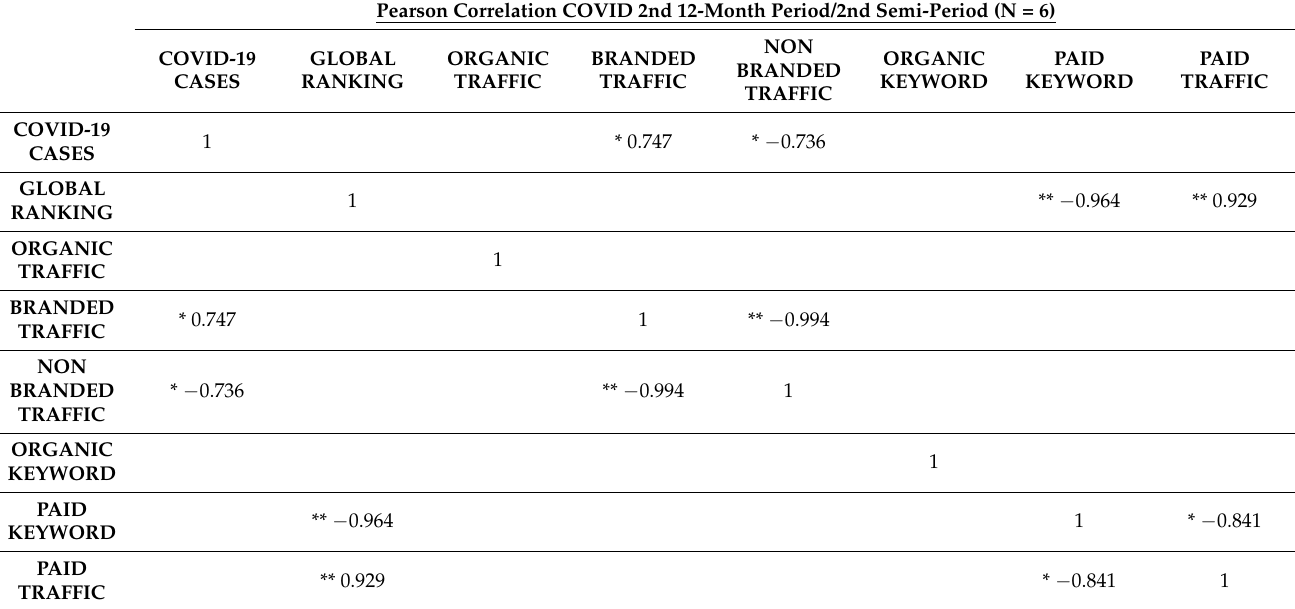
Table 8. Statistically significant correlation matrix after PCC–r analysis (COVID 2nd 12-month period/2nd